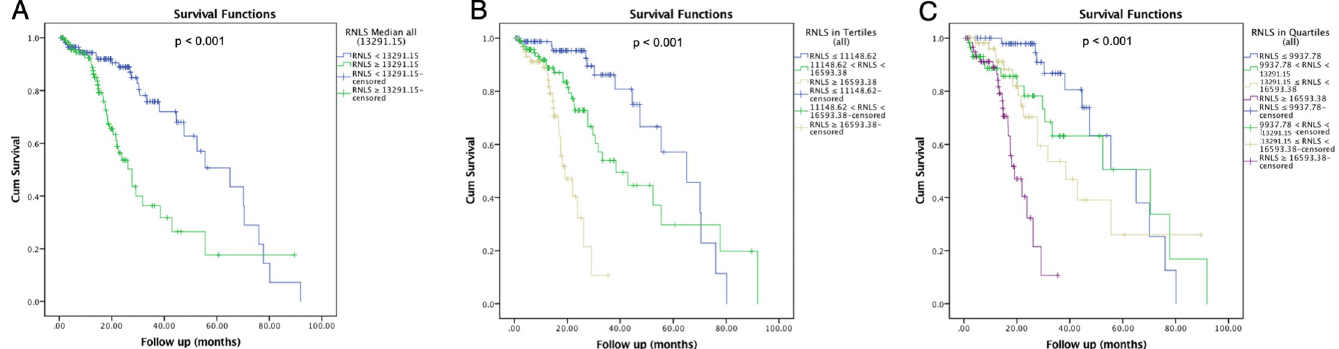
Fig 4. High plasma RNLS levels are associated with worse survival in patients with PDAC. (A) When RNLS is cut by median, (B) by tertiles, and (C) by quartiles.